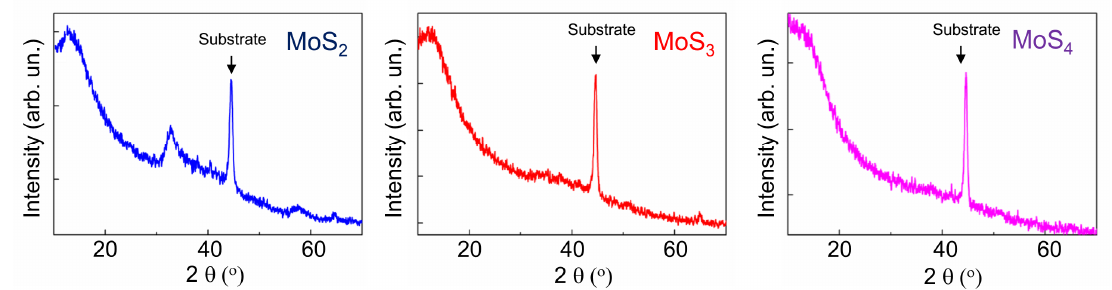
Figure 2. XRD patterns for different MoS x films obtained through RPLD in H 2 S gas on the steel